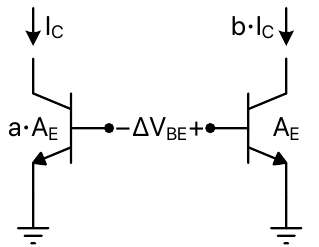
Figure 2. BJT pair for ∆ V BE signal